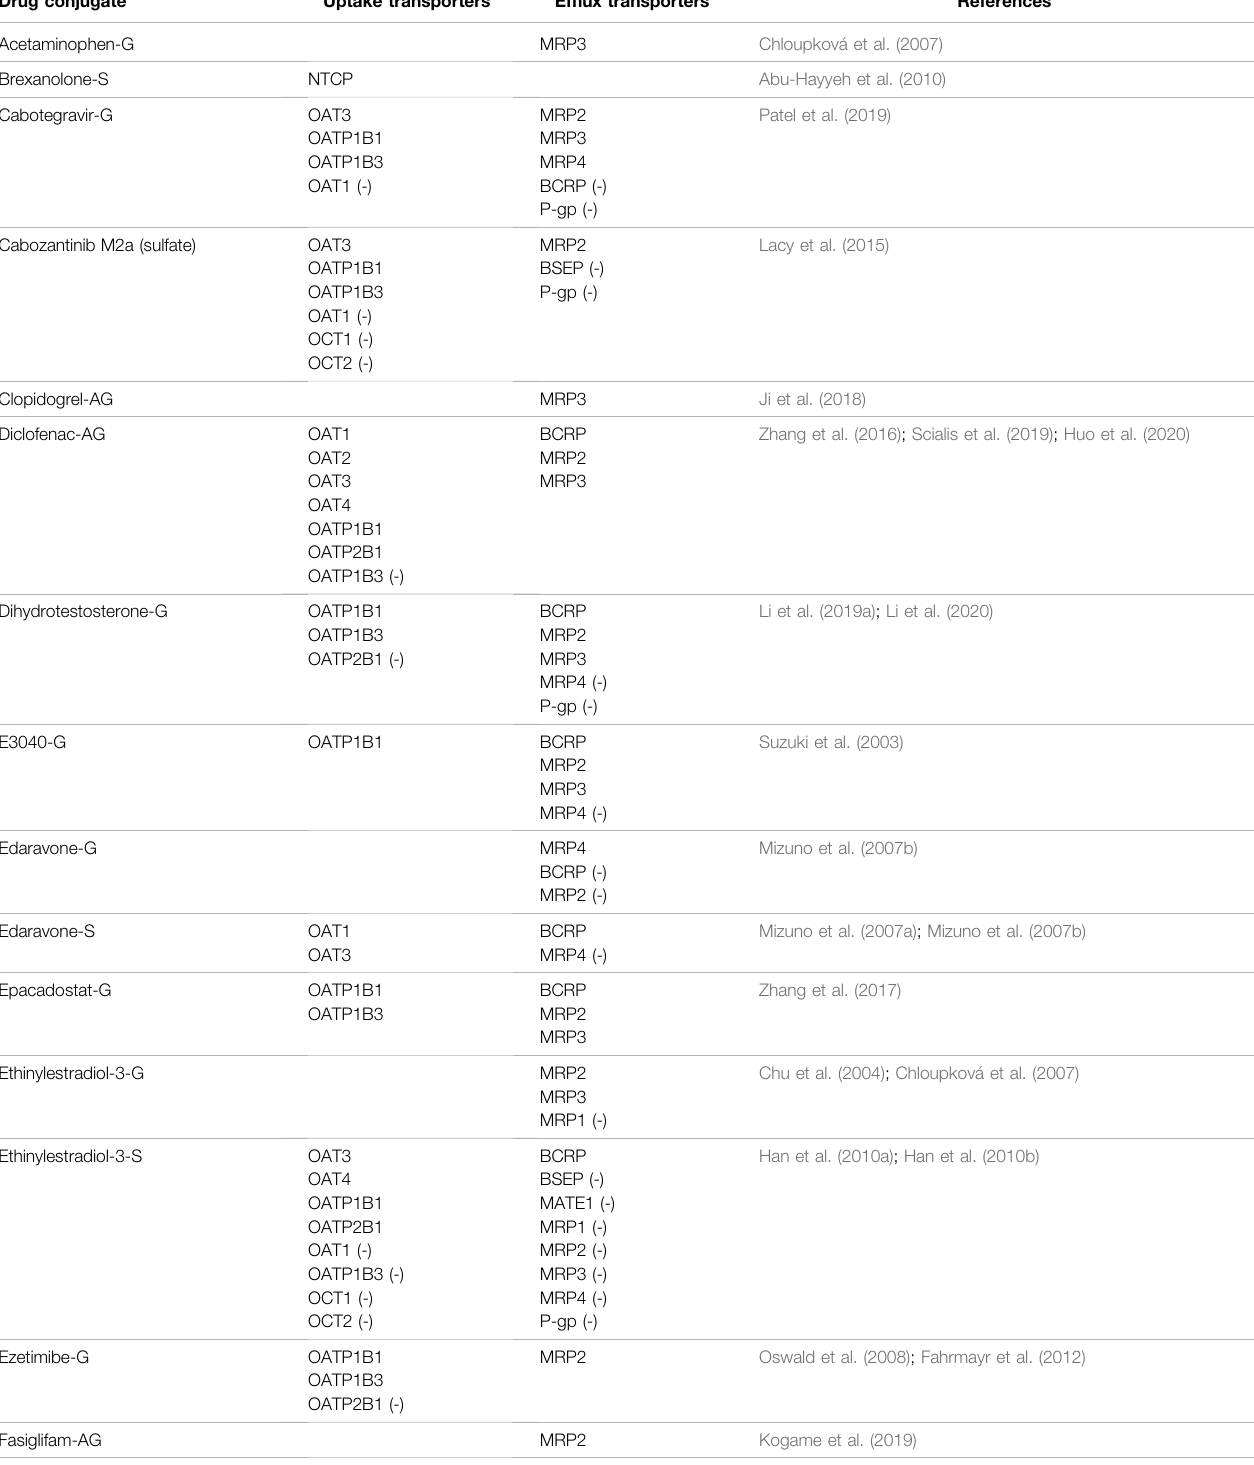
TABLE 1 | Drug glucuronides (-G and -AG) and sulfates (-S) studied as substrates in transporter overexpression